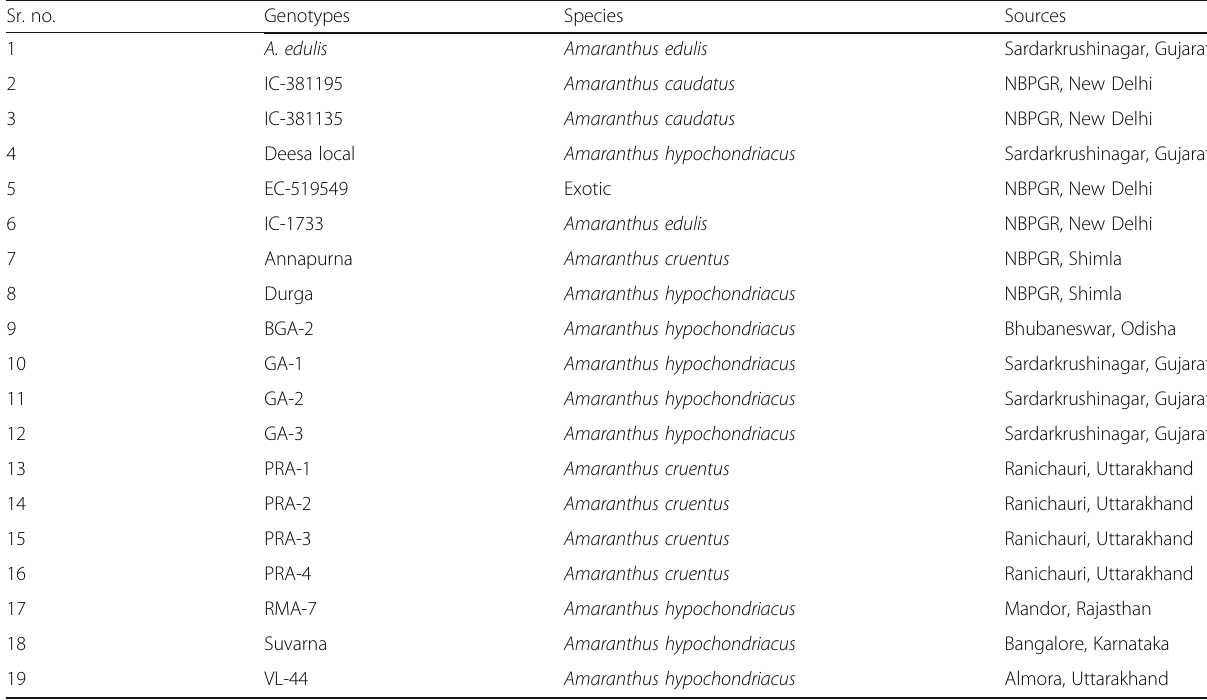
Table 1 List of grain amaranth genotypes used in the study Sr. no.